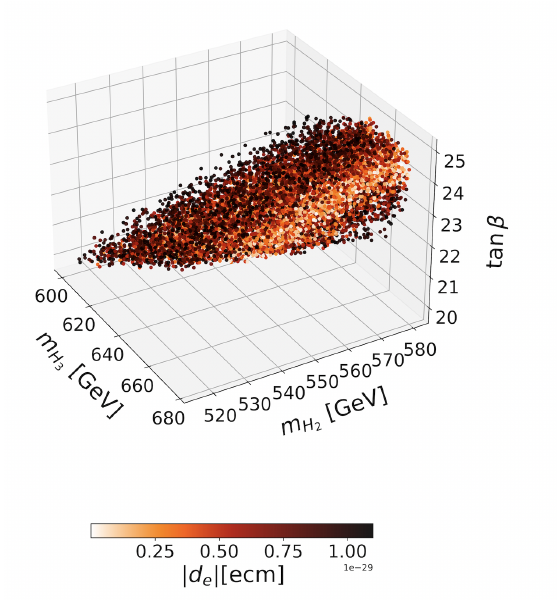
Figure 5 . Parameter space points from the very fine grained scan, projected over the two masses and tan β . The color code denotes the magnitude of the electron dipole moment d e